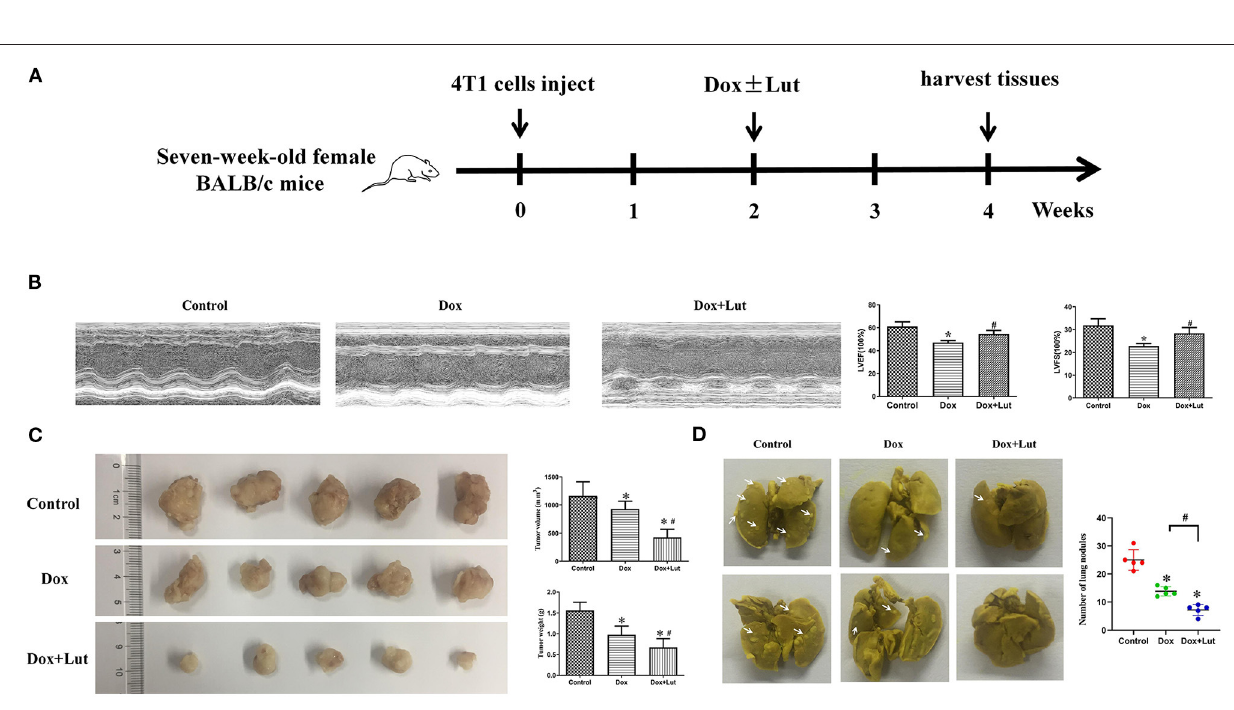
Frontiers in Cardiovascular Medicine | www.frontiersin.org